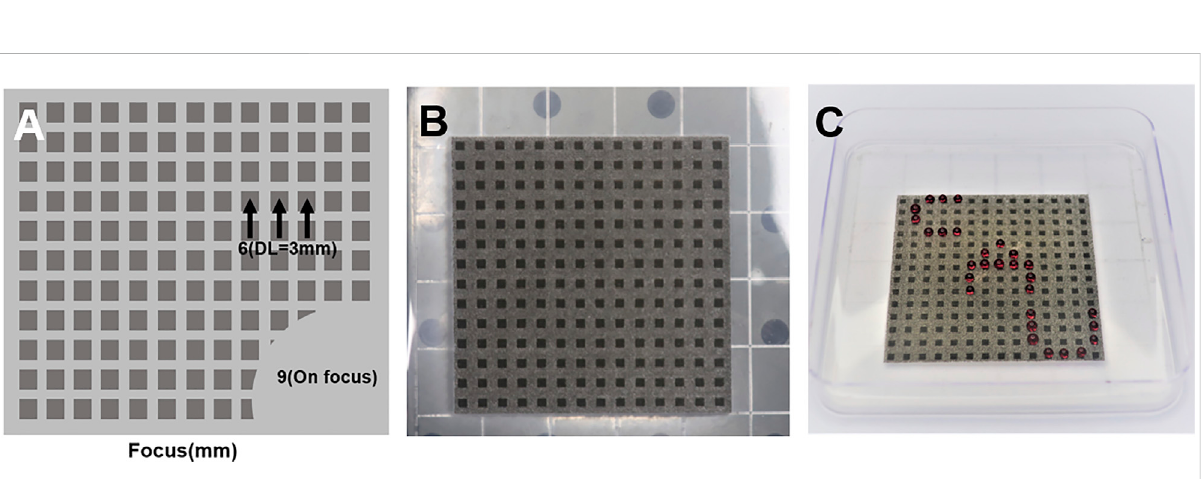
FIGURE 6 Laser etching of 14*14 square arrays for droplet modulation. (A) Superhydrophobic grid manufacture. (B) Superhydrophobic grid diagram on silicone. (C) Droplets on a superhydrophobic grid forming the letters “ CAU.